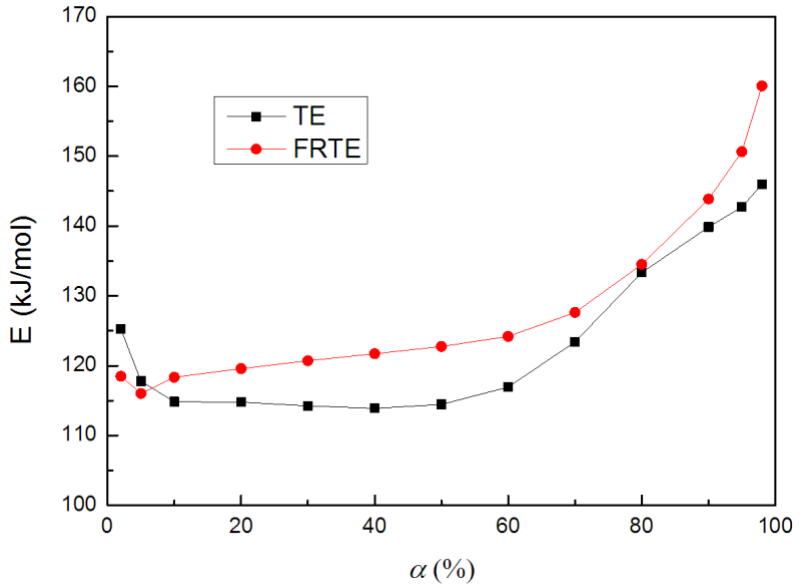
Figure 9. The curves of lg ( β ) vs. 1000/ T of TE ( a ) and FRTE ( b ).